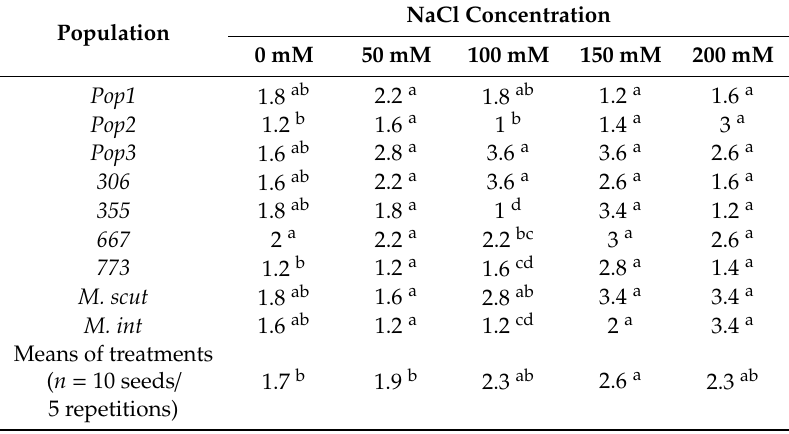
Table 3. Germination rate (T50) under salt stress (0, 50, 100, 150, 200 mM NaCl) of seven populations of M. ciliaris ( Pop1, Pop2, Pop3, 306, 355, 667, 773 ), one population of M. intertexta ( M. int ), and one population of M. scutellata ( M. scut ). The values are the averages of 10 seeds and five replications. Di ff erent letters indicate a significant di ff erence at p < 0.05, Tukey’s post hoc